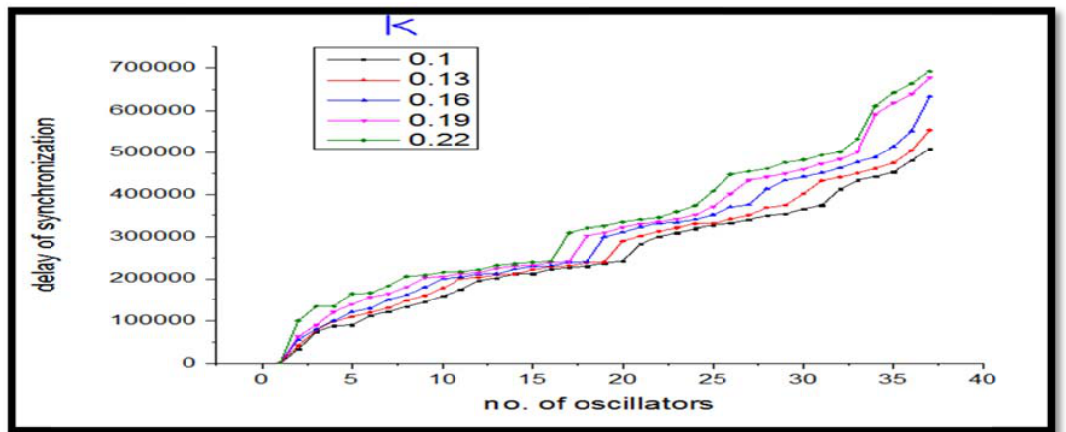
of synchroni ization for 3